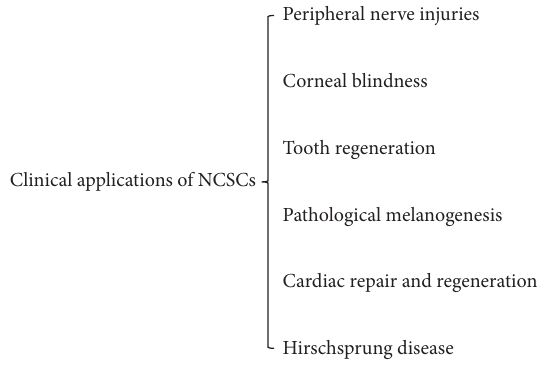
Figure 1: A summary of NCSC clinical